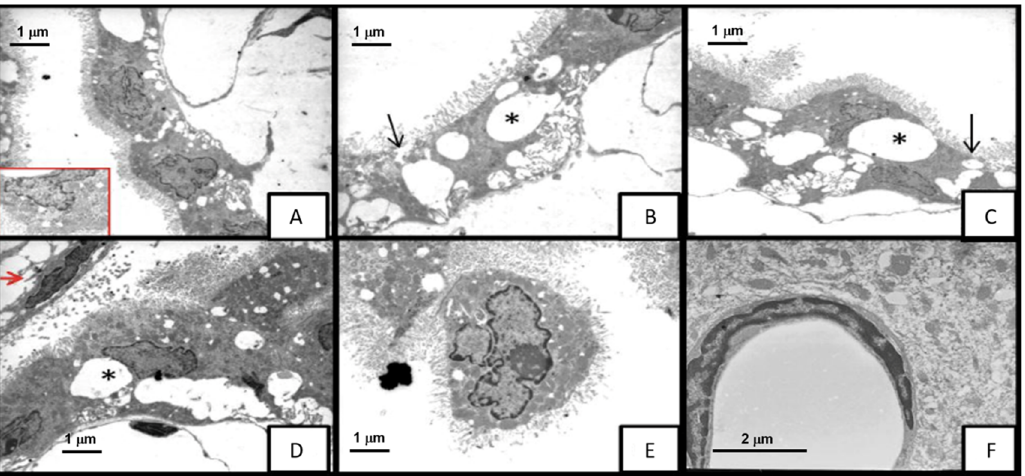
Figure 4. Electron micrograph showing the morphological changes in mice infected with M. tuber- culosis H37Rv strain at 21DPI. ( A – D ) Choroid plexus cells with intracytoplasmic vacuolation *, cell membrane alterations and tight junction separation (arrows), ( D ) presence of Kolmer or epiplexus cells (red arrow) × 8000. ( E ) The ependymal cell completely separated from the others, with shorten- ing of the microvilli × 8000. ( F ) Hippocampal blood vessel showing endothelial cell without apparent alterations ×